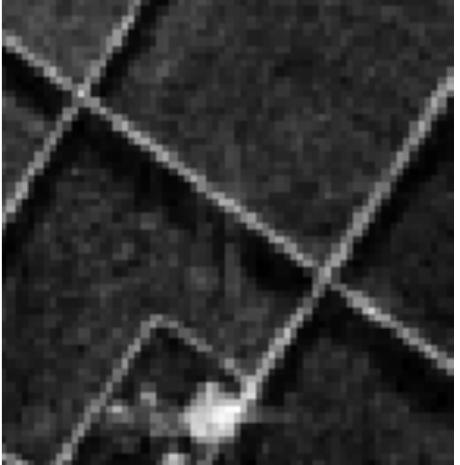
Figure 2. The RD image with full echo data.